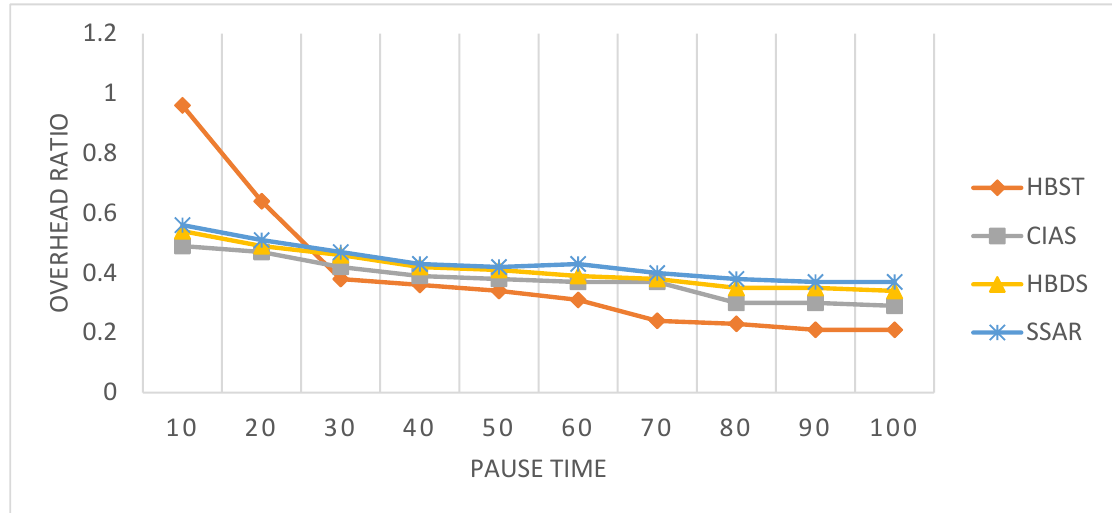
Figure 7. Routing overhead ratio for the network with 50% selfish nodes.